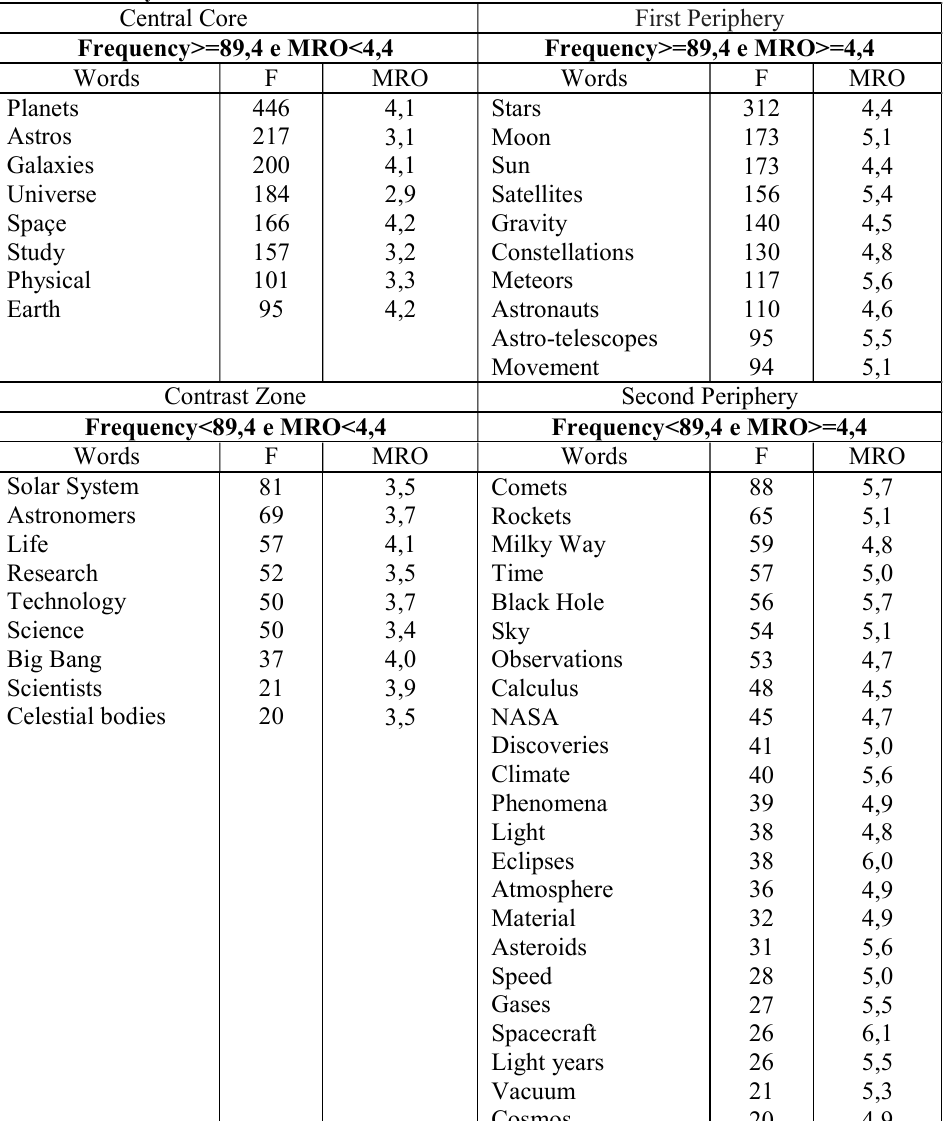
Table 3: Four-house chart showing the social representations of Astronomy elaborated by the students surveyed.